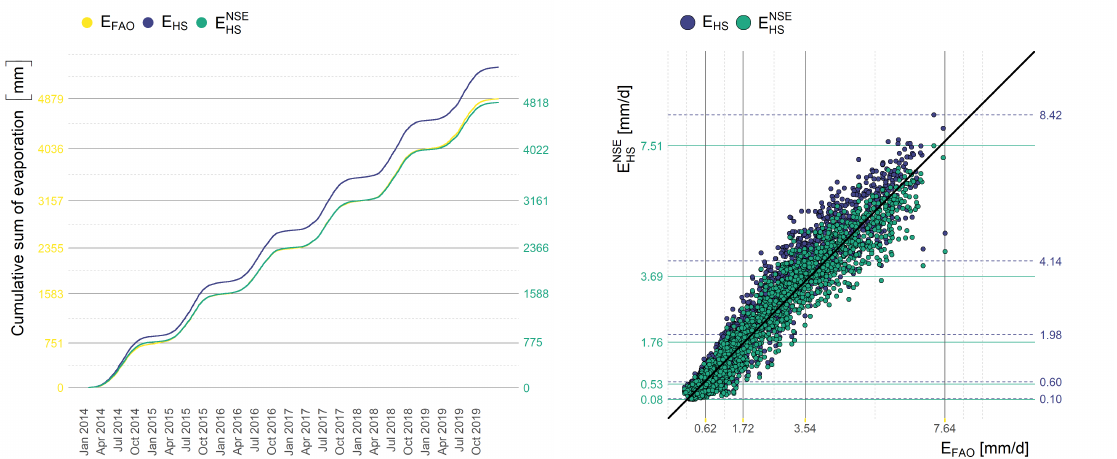
Figure 9. The comparison of the daily evaporation computed by FAO Penman–Monteith equation, Hargreaves–Samani equation, and calibrated Hargreaves–Samani equation with respect to NSE in the form of cumulative evaporation ( left ) and the scatter plot ( right ).